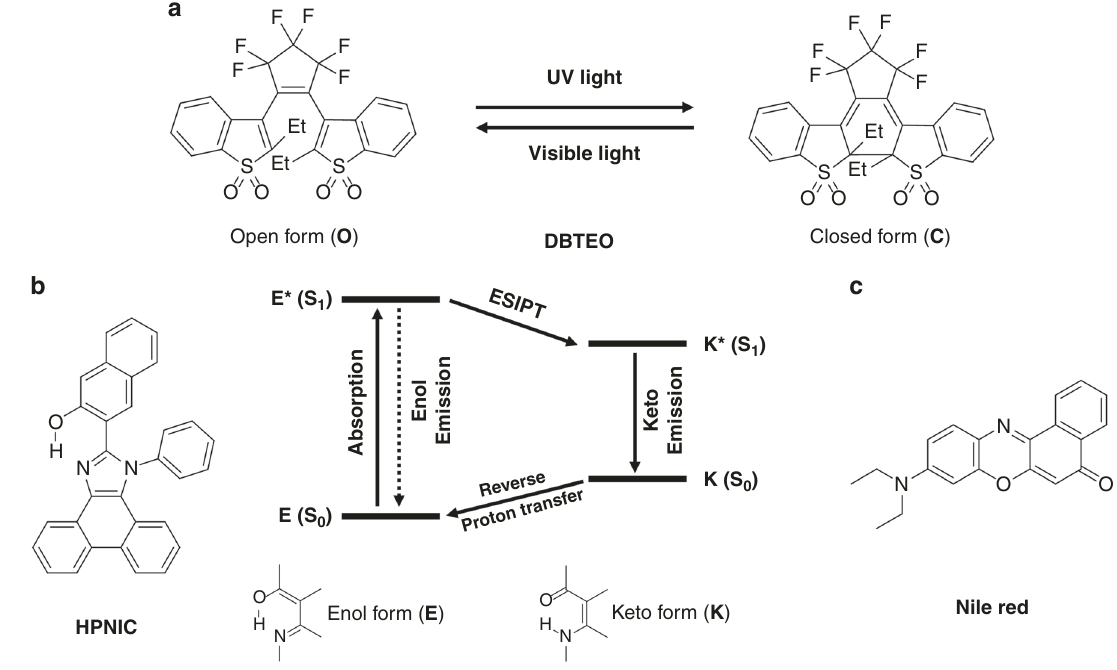
Fig. 2 Molecular structures and photochemical reactions. a Chemical structure and photochromic reaction of DBTEO. b Chemical structure of HPNIC and schematic illustration of the ESIPT process. c Chemical structure of Nile